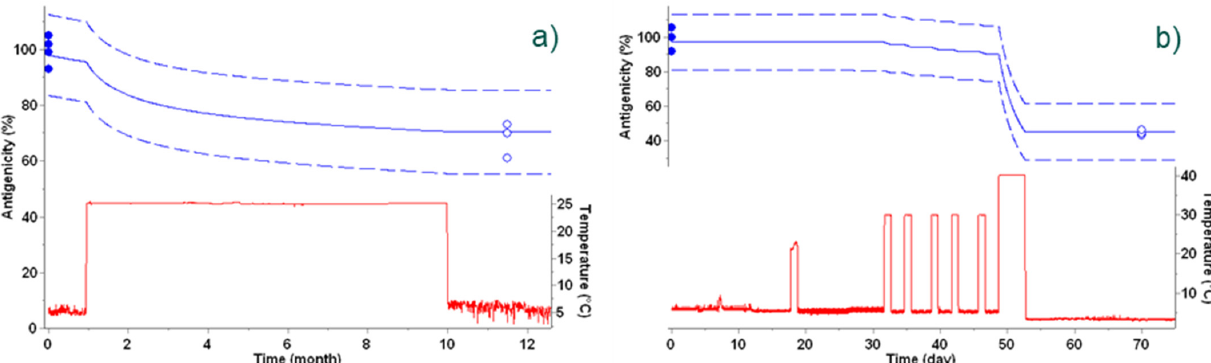
Figure 5. Vaccine antigenicity predicted from the best kinetic model during temperature excursions outside the cold-chain. ( a ) Temperature fluctuation experienced by a vaccine during storage for 12 months including a temperature excursion for 9 months in incubator set at +25 °C is displayed as a red line. Antigenicity predictions are displayed as blue lines, including the 95% prediction band as dashed lines. Experimental data determined at t-zero and at the end of temperature excursions are displayed as blue circles. Open circles were not used for kinetic modeling, but for verification. ( b ) Temperature fluc- tuations experienced by a vaccine during storage for 100 days, including successive temperature excursions at +20 °C and in an incubator set at +40 °C, displayed as a red line. Antigenicity predictions are displayed as blue lines, including the 95% prediction band as dashed lines. Experimental data determined at t-zero and at the end of temperature excursions are displayed as blue circles. Open circles were not used for kinetic modeling, but for verification.